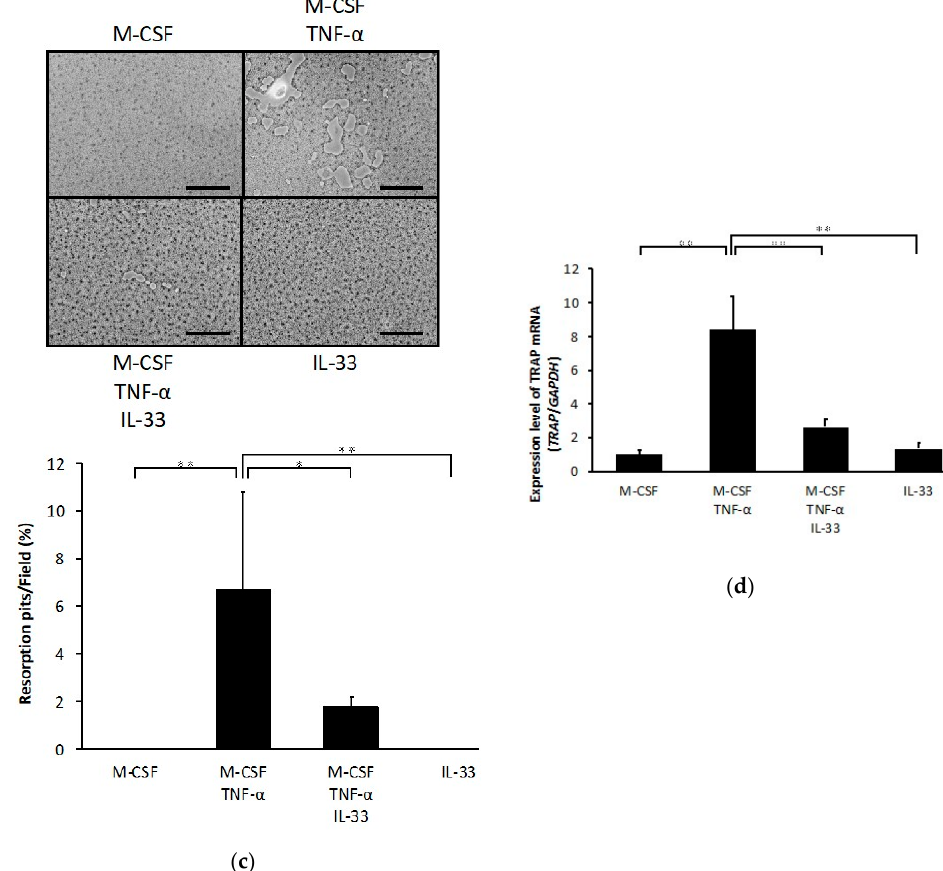
Figure 1. Interleukin (IL)-33 inhibited receptor activator of nuclear factor kappa-B ligand (RANKL)- and tumor necrosis factor- α (TNF- α )-induced osteoclast formation in vitro. ( a ) Microscopic images and the number of TRAP-positive cells of osteoclast precursors cultured with macrophage colony stimulating factor (M-CSF), M-CSF + RANKL, M-CSF + RANKL + IL-33, or IL-33. ( b ) Microscopic images and the number of TRAP-positive cells of osteoclast precursors cultured with M-CSF, M-CSF + TNF- α , M-CSF + TNF- α + IL-33, or IL-33. TRAP-positive cells with ≥ 3 nuclei were considered to be osteoclasts. ( c ) Microscopic images and the percentage of resorption pits. ( d ) Tartrate-resistant acid phosphatase (TRAP) mRNA levels of osteoclasts detected using real-time RT-PCR. Results are ( n = 4; * p < 0.05, ** p < 0.01). Scale bars = 200 µm.